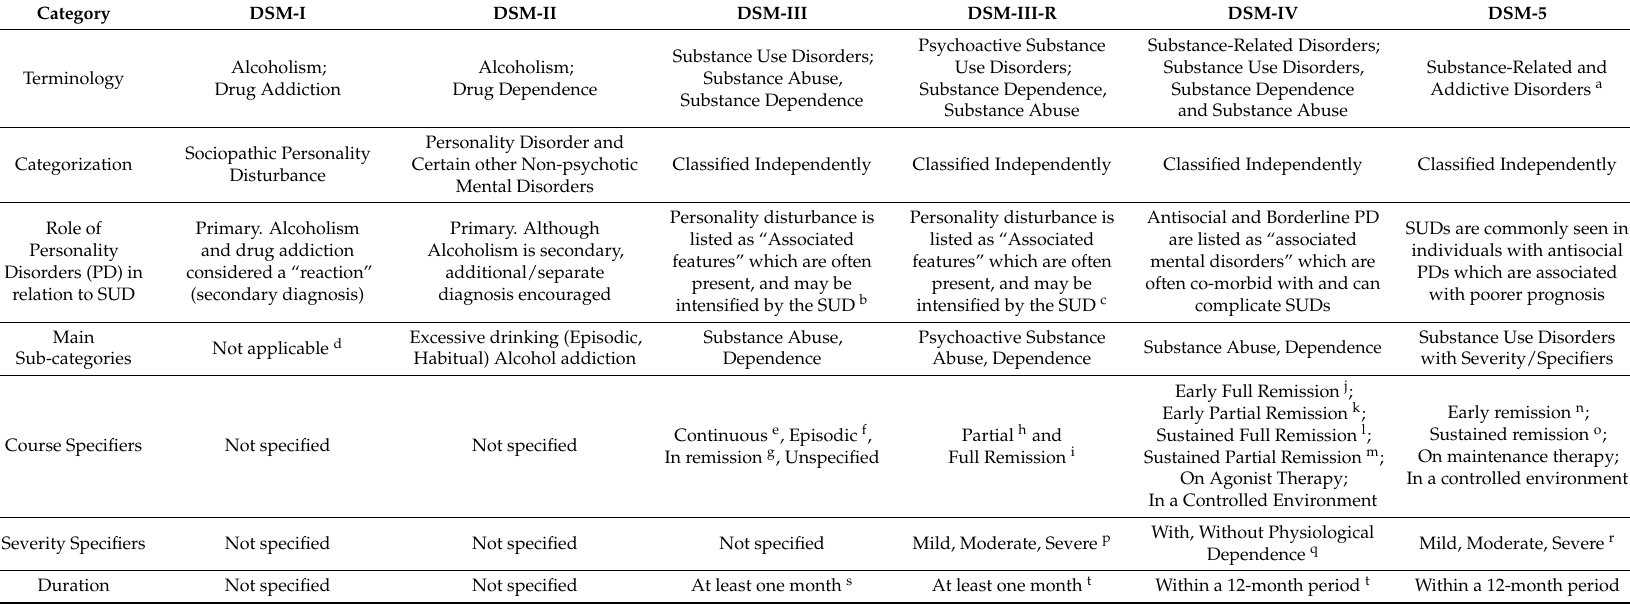
Table 1. Selected Diagnostic Considerations Comparing DSM-5 to earlier versions related to Alcohol and Substance Use